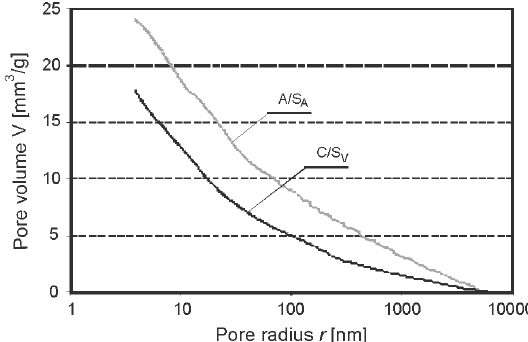
Fig. 6. Porosity characteristics of compared concretes A/S A and C/S V in pore range of 5–7500 nm (pore volume V versus pore radius r )